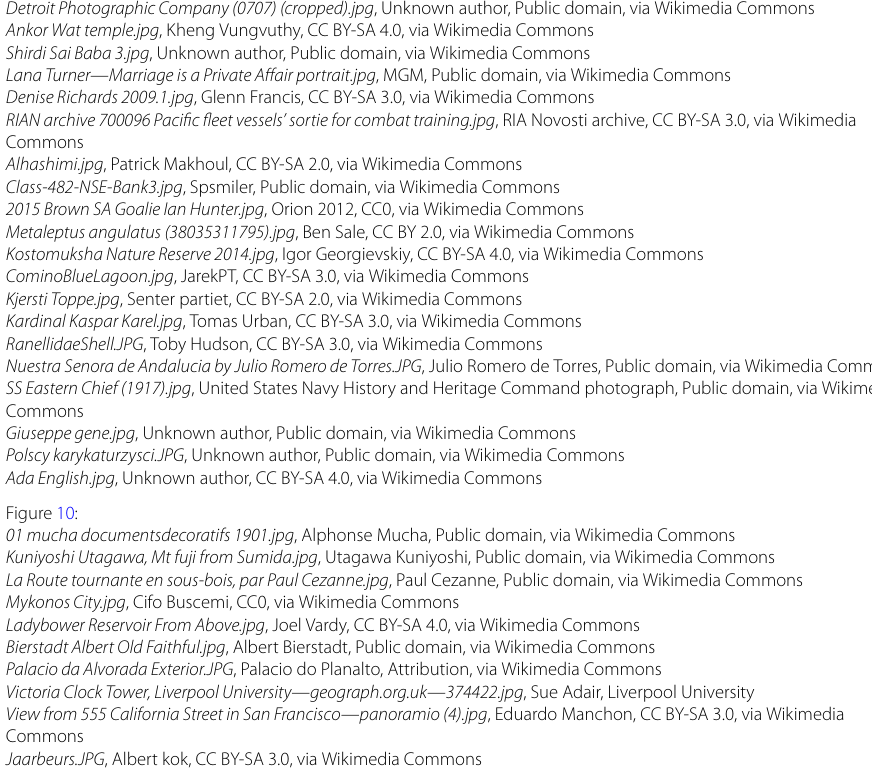
Figure 8: DetroitPhotographicCompany(0707)(cropped).jpg , Unknown author, Public domain, via Wikimedia